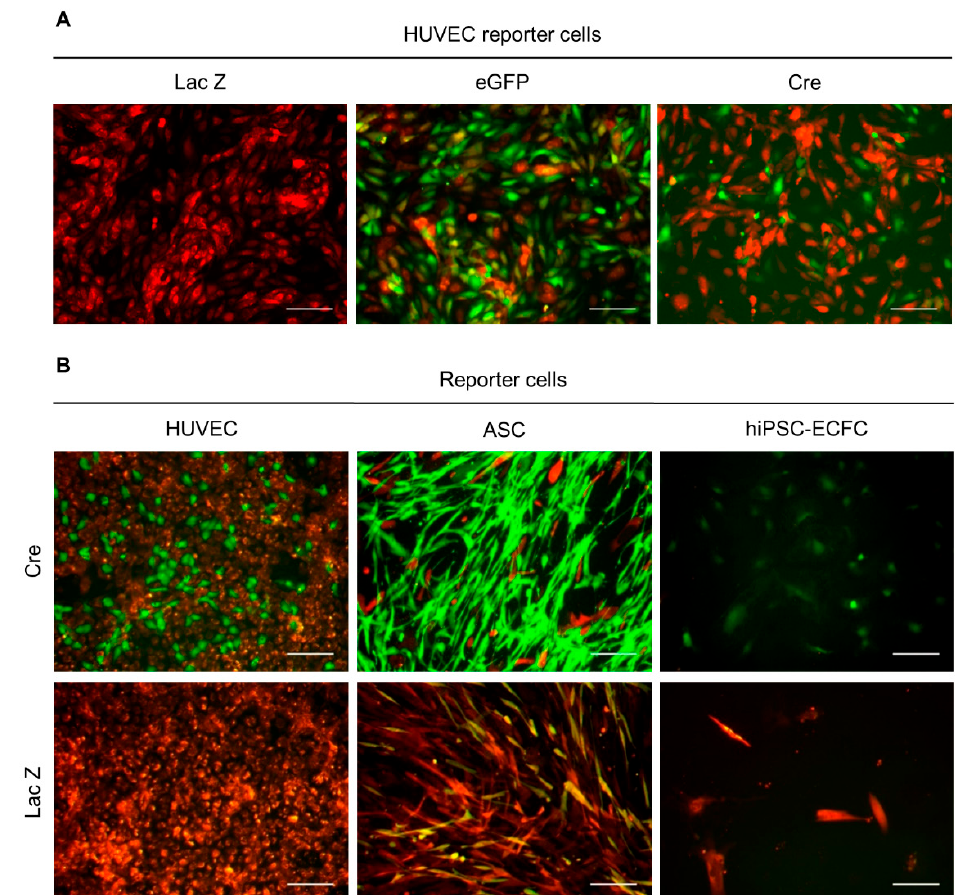
Figure 2. Functionality control of the Cre construct and reporter gene. ( A ) HUVEC reporter cells were retrovirally transduced with a control construct (lacZ), eGFP, and the Cre construct. Data presented were obtained from one experiment. ( B ) HUVEC, ASC, and hiPSC-ECFC reporter cells were transfected with the Cre construct and control construct (lacZ). Data presented was obtained from two independent experiments using two different donors for HUVEC and ASC and one cell donor for hiPSC-ECFC. Scale bar: 100 µm.